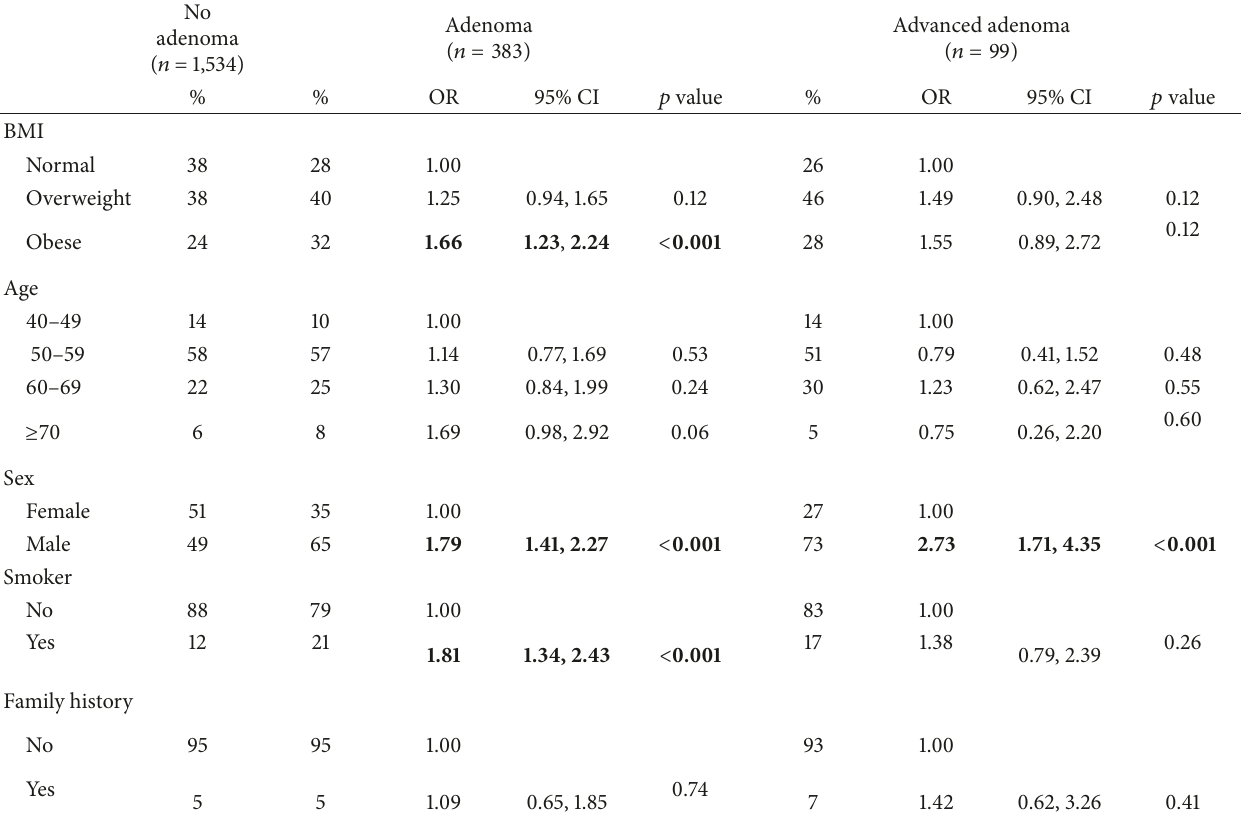
Table 3: OR for A or ADV adjusted for BMI, age, sex, and smoking